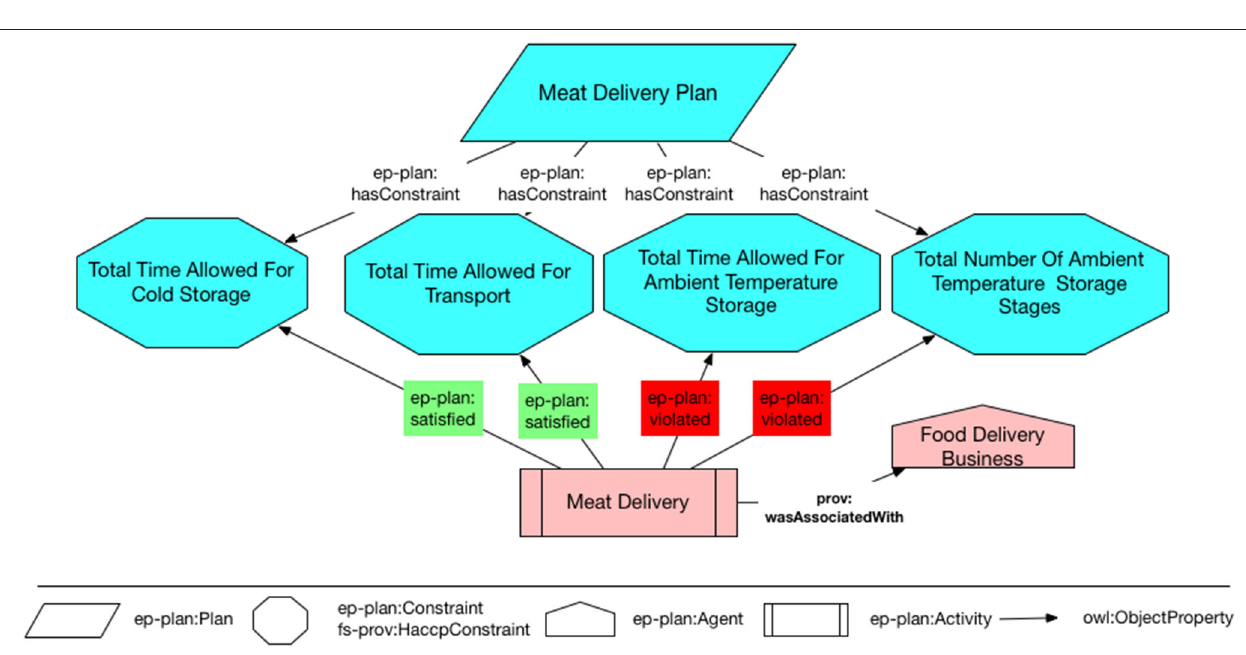
Frontiers in Sustainable Food Systems |